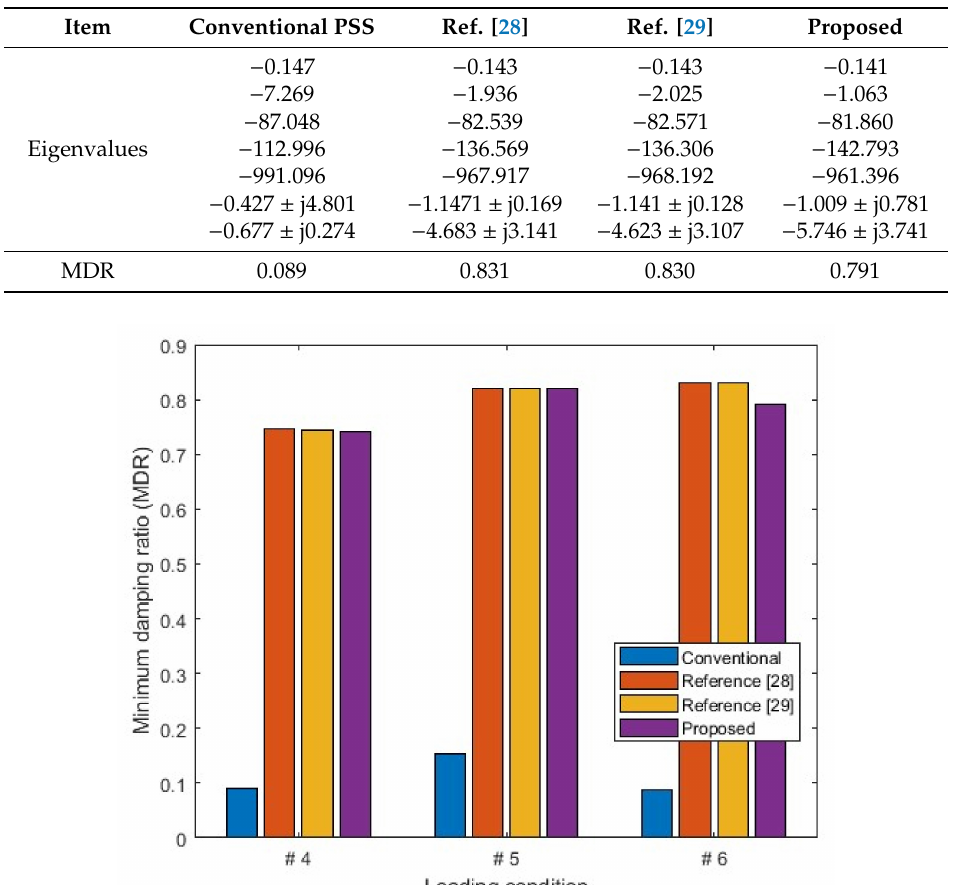
Table 13. Eigenvalues and MDR comparison for the operating situation # 6 (second network).